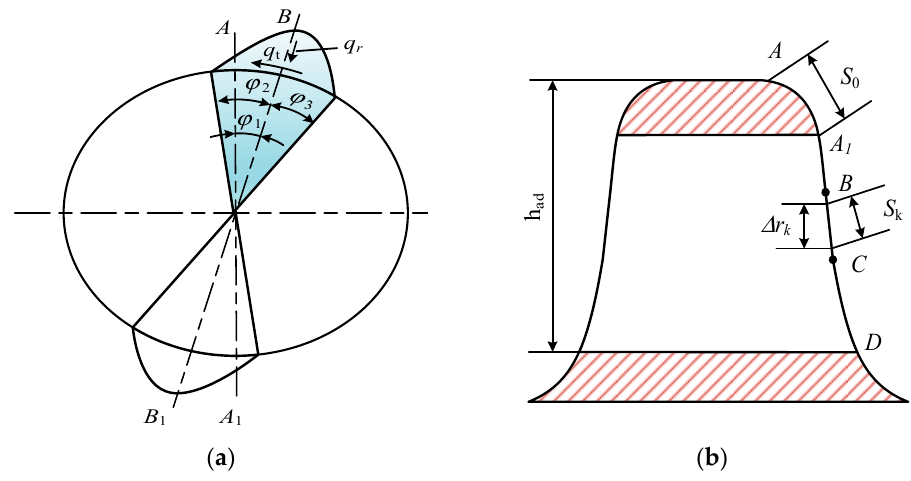
Figure 6. Gear teeth load distribution: ( a ) in its entirety, and ( b ) for a single tooth.